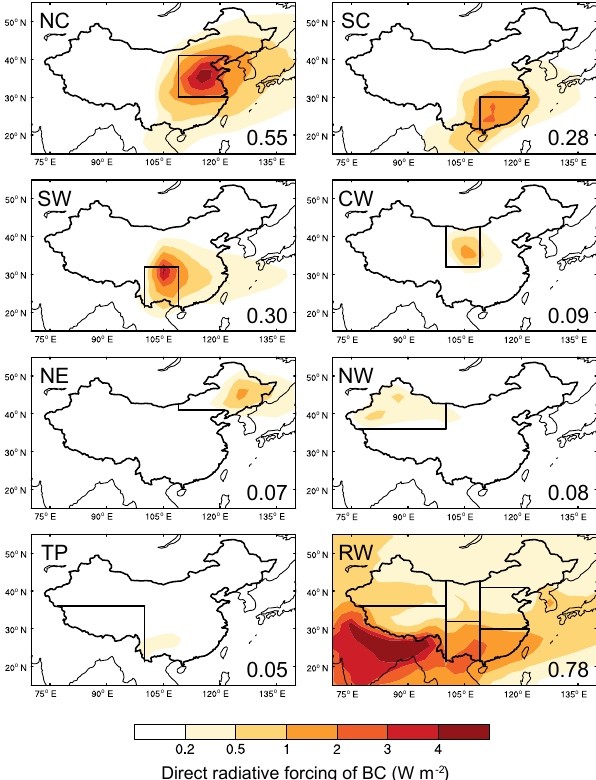
Figure 11. Spatial distribution of annual mean direct radiative forc- ing of BC (Wm − 2 ) at the top of the atmosphere originating from the tagged BC source regions in China (NC, SC, SW, CW, NE, NW and TP) and sources outside China (RW). The regionally averaged forcing in China contributed by individual source regions is shown at the bottom right of each